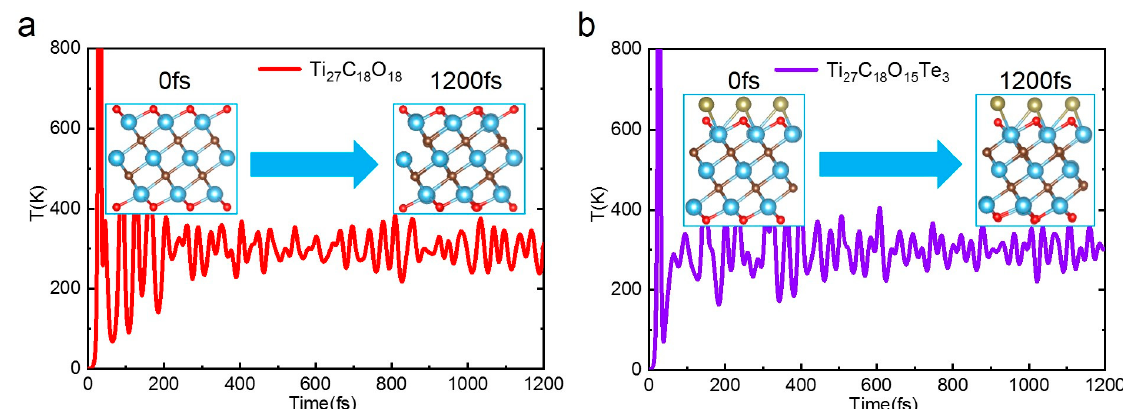
Figure 6. Ab initio molecular dynamics (AIMD) verification: ( a ) AIMD of 2D-Ti 2 CO 2 at 300 K of canonical ensemble (NVT ensemble); ( b ) AIMD of Ti 27 C 18 O 17 Te 3 at 300K of NVT ensemble; the illustrated structure shows the initial and final structural sketch.